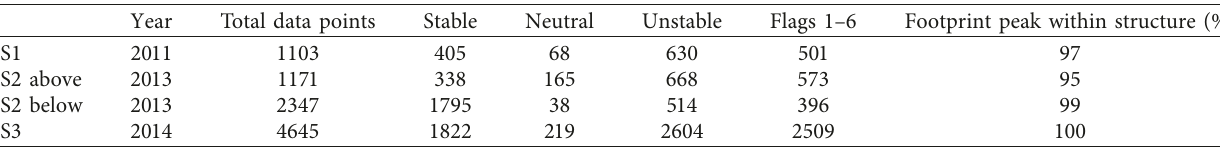
Columns from left to right represent campaign code, year, total number of available data points, number of data points under stable conditions, number of data points under neutral conditions, number of data points under unstable conditions, number of data points with quality flags 1–6, and percentage of data points whose flux footprint peak is within the